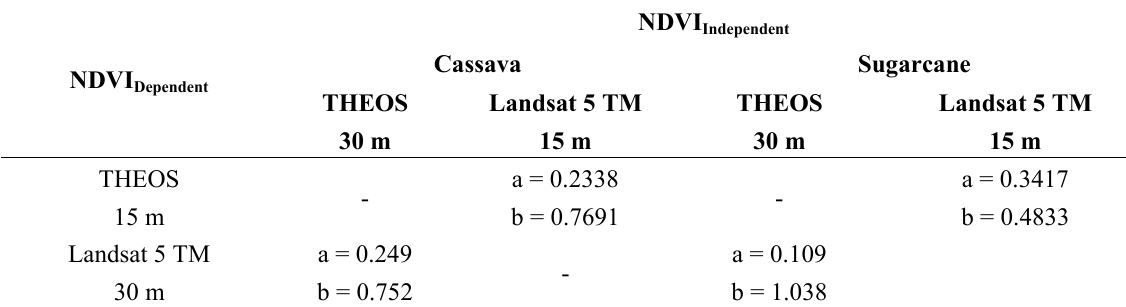
Table 8. NDVI intercept ( a ) and slope ( b ) coefficients for THEOS and Landsat 5 TM satellite sensors relationships for cassava and sugarcane. NDVI Independent Cassava NDVI Dependent